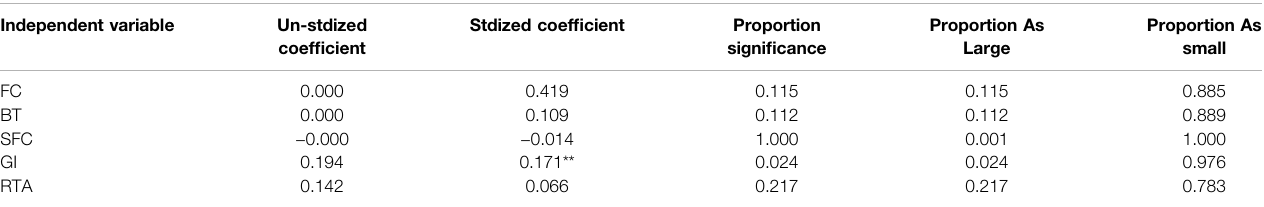
Stdized coef fi cient Proportion coef fi cient